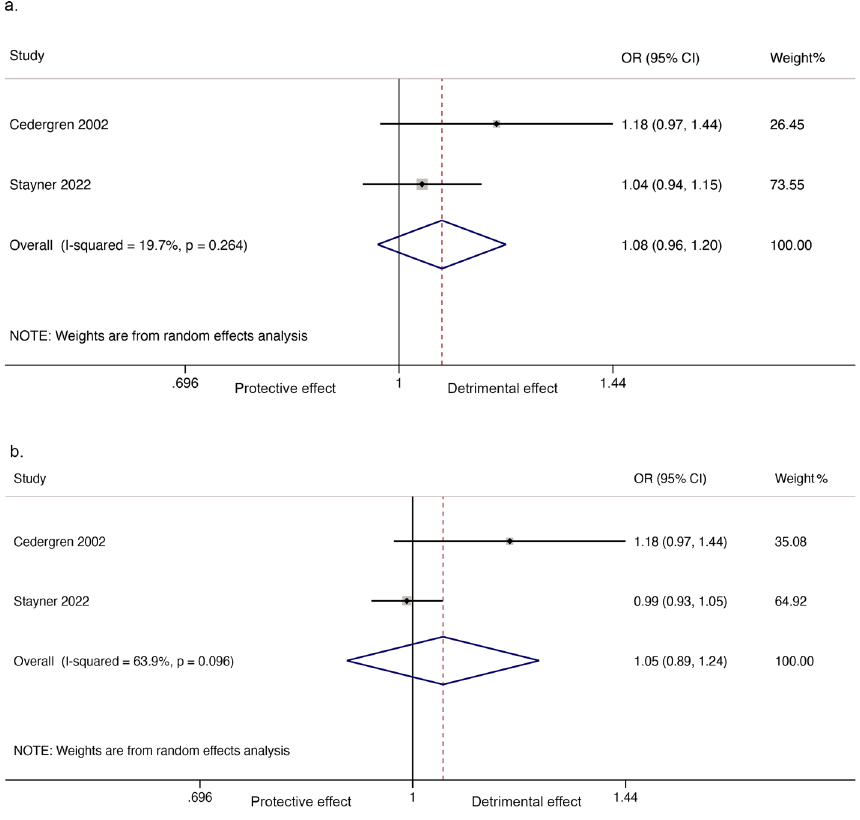
Figure 5. Forest plot for the association between nitrate in drinking water and any heart defects. ( a ) Highest versus the lowest exposure; ( b ) All combined higher versus the lowest